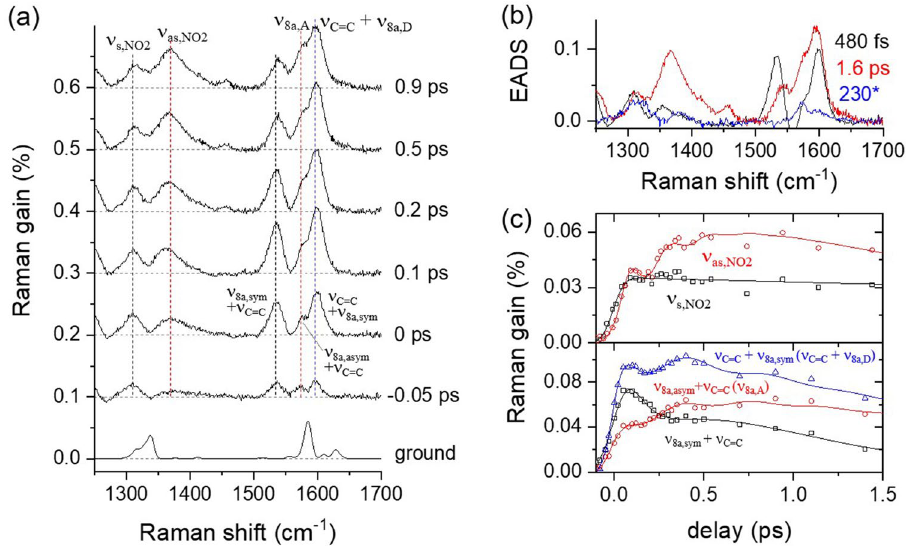
Figure 5. Femtosecond stimulated Raman spectroscopy (FSRS) of 4-dimethylamino-4 ′ -nitrostilbene (DNS) with 403 nm excitation; ( a ) time-resolved Raman spectra compared to the ground state spectrum, ( b ) evolution- associated difference spectra (EADS) from the global analysis of excited state Raman spectra, ( c ) kinetic traces for the major vibrational modes of ν NO2 , ν C=C , and ν 8a modes of phenyl. The vibrational modes outside the parentheses denote the DNS modes with the planar geometry and those inside the parentheses represent the vibrational modes with the twisted nitrophenyl